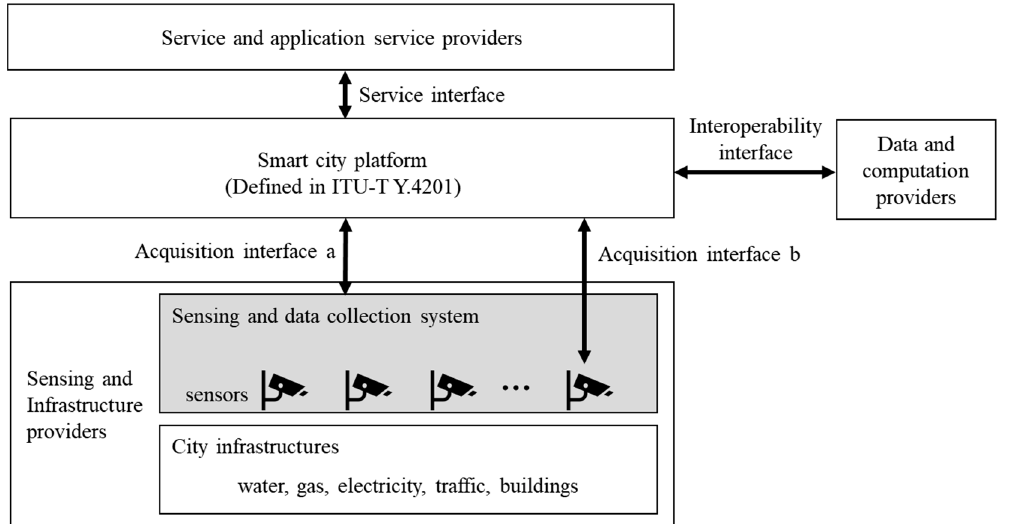
Figure 4. Interoperability of SCP and city infrastructure.